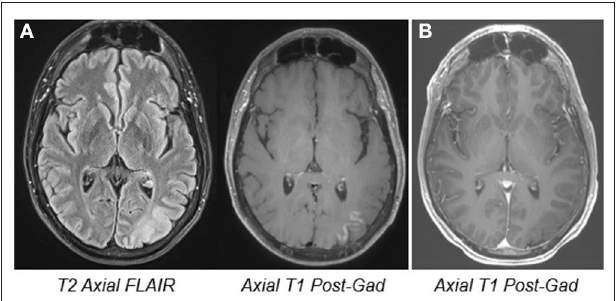
FIGURE 1 | MRI images. Pre- (A) and 6 month post-treatment MRI (B) showing left occipital cortical thickening and blurring of gray-white junction, implying the presence of a focal cortical dysplasia. The pre-treatment cortical enhancement resolved at the follow-up study.